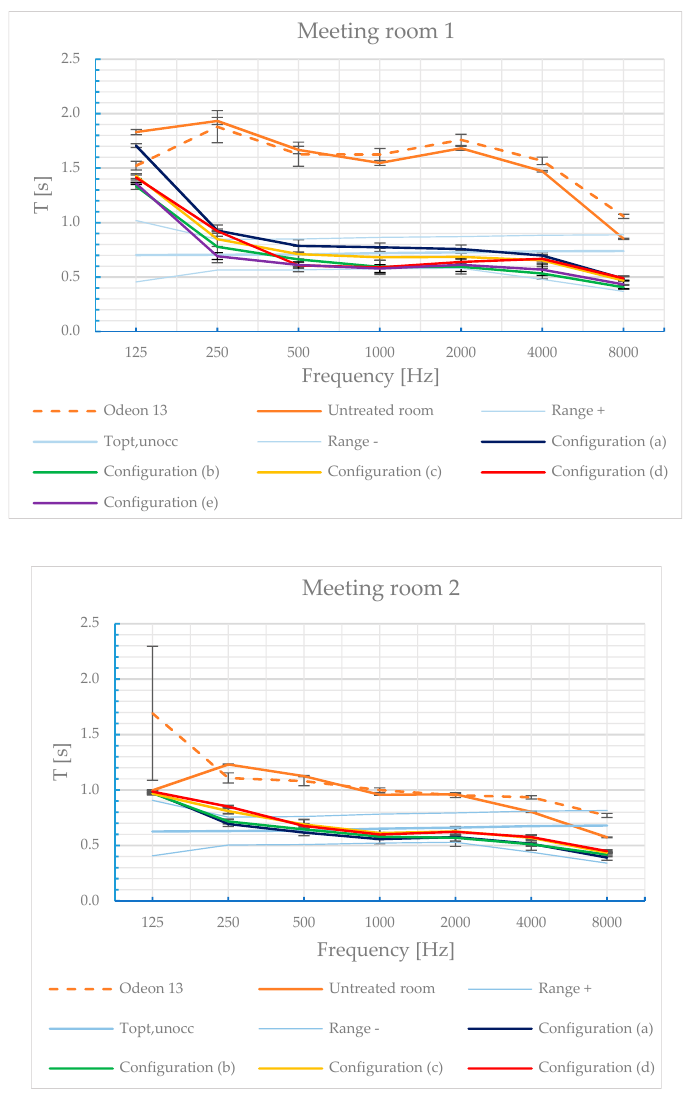
Figure 10. Octave band Reverberation Time in the Mr1 and Mr2 measured with ODEON 13 in the untreated room and simulated with ODEON 15 for the untreated room and for the different configurations shown in Figures 5 and 6. Optimal Reverberation Time in unoccupied conditions, T opt,unocc , with its target range as a function of frequency, is also shown. The error bars represent the standard deviation across different measurement positions.